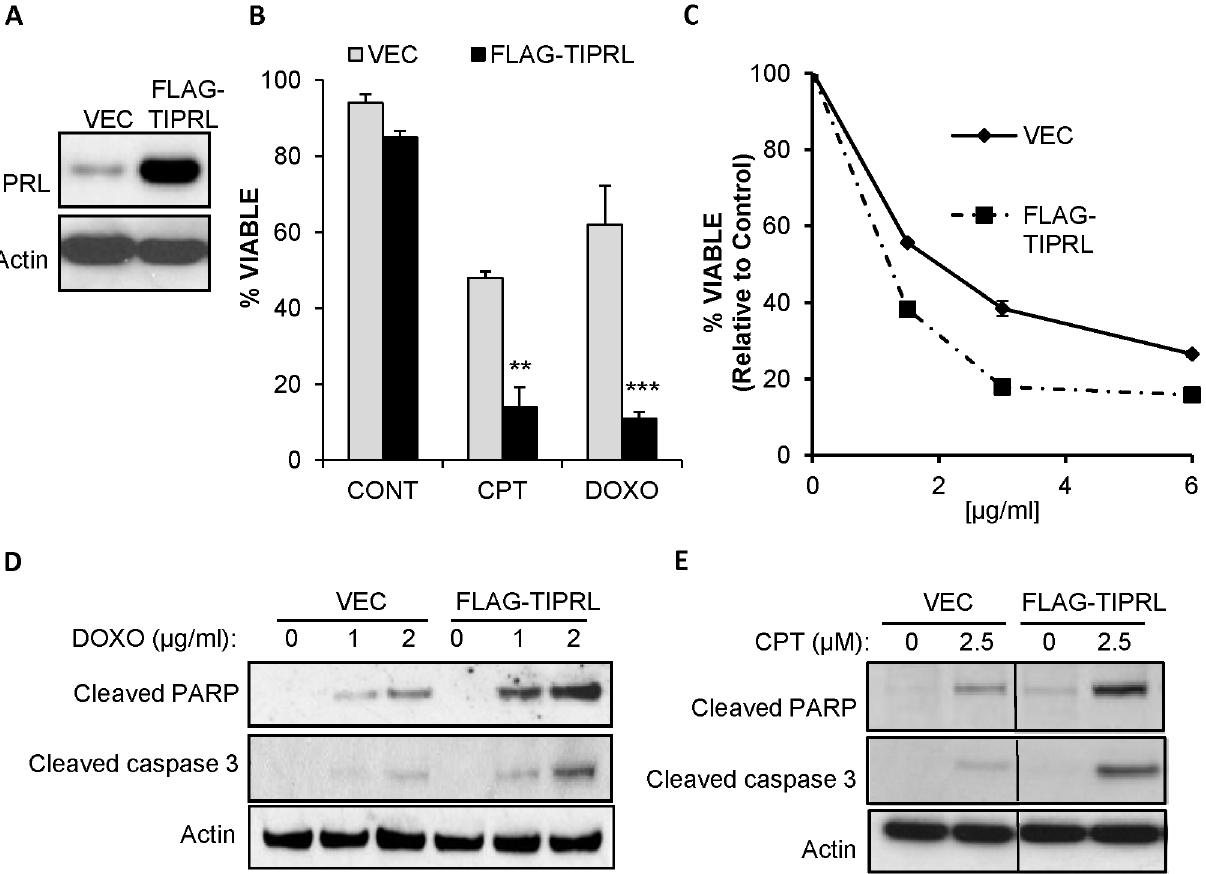
Fig 5. Overexpression of TIPRL promotes cell death in response to genotoxic stress. (A) 3T3 MEFs stably expressing LPC FLAG vector control (VEC) or LPC FLAG-TIPRL (FLAG-TIPRL) were lysed and immunoblotted with the indicated antibodies. (B) Cells were treated with 10 μ M CPT or 2 μ g/ml doxorubicin for 24hrs. Viability was measured by propidium iodide exclusion. Data represent ± standard deviation of the mean of three independent experiments. (C) 3T3 MEFs stably expressing LPC FLAG vector control (VEC) or LPC FLAG-TIPRL (FLAG-TIPRL) were treated with the indicated concentration of doxorubicin (DOXO) for 24hrs. Cell viability was measured by MTS assay. (D) 3T3 cells stably expressing LPC FLAG vector control (VEC) or LPC FLAG-TIPRL (FLAG-TIPRL) were treated with the indicated concentration of doxorubicin (DOXO) for 24hrs. Cells were lysed and immunoblotted with the indicated antibodies. (E) 3T3 MEFs stably expressing LPC FLAG vector control (VEC) or LPC FLAG-TIPRL (FLAG-TIPRL) were treated with the indicated concentration of CPT for 24hrs. Cells were lysed and immunoblotted with the indicated antibodies. ** p < 0.005, *** p < 0.001, Student ’ s t test.